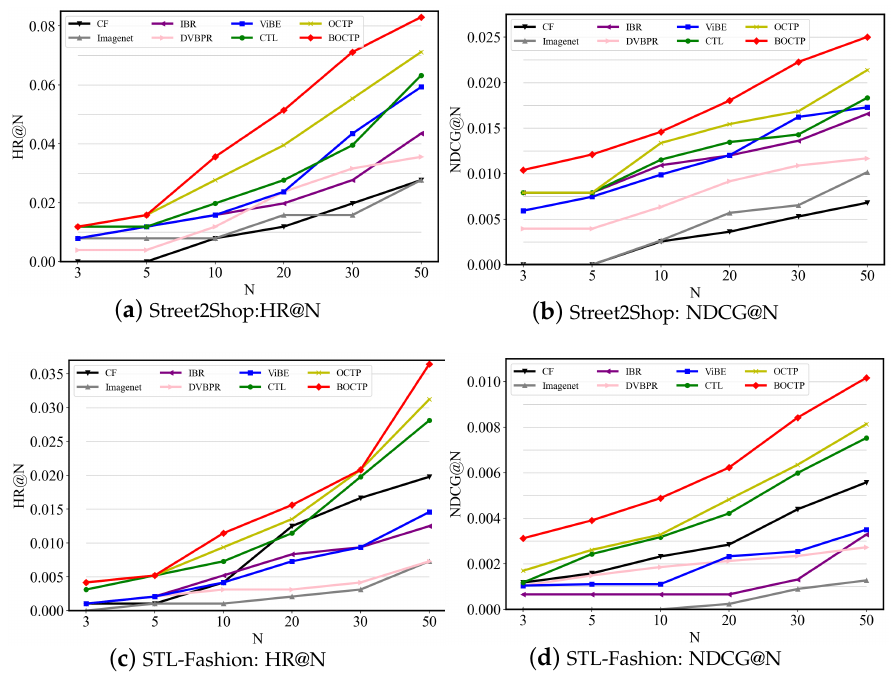
Figure 7. HR@N and NDCG@N on Street2Shop and STL-Fashion ‘all’ datasets for a non-label-given task, where N ∈ { 3,5,10,20,30,50 }